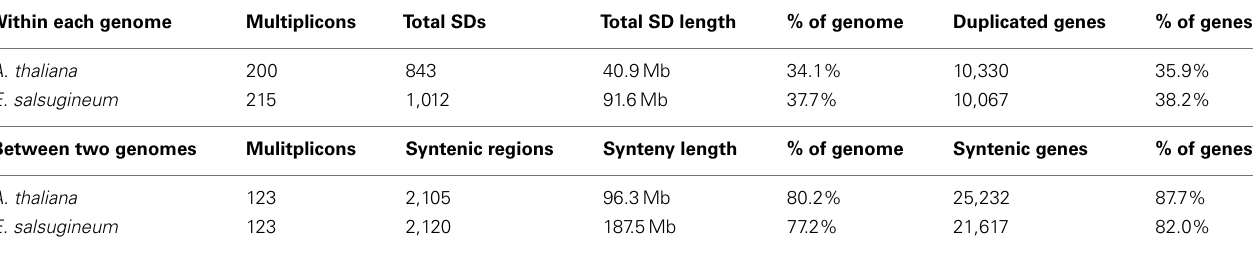
Table 4 | Identification of duplication events in each genome and genomic synteny between A. thaliana and E. salsugineum. Within each